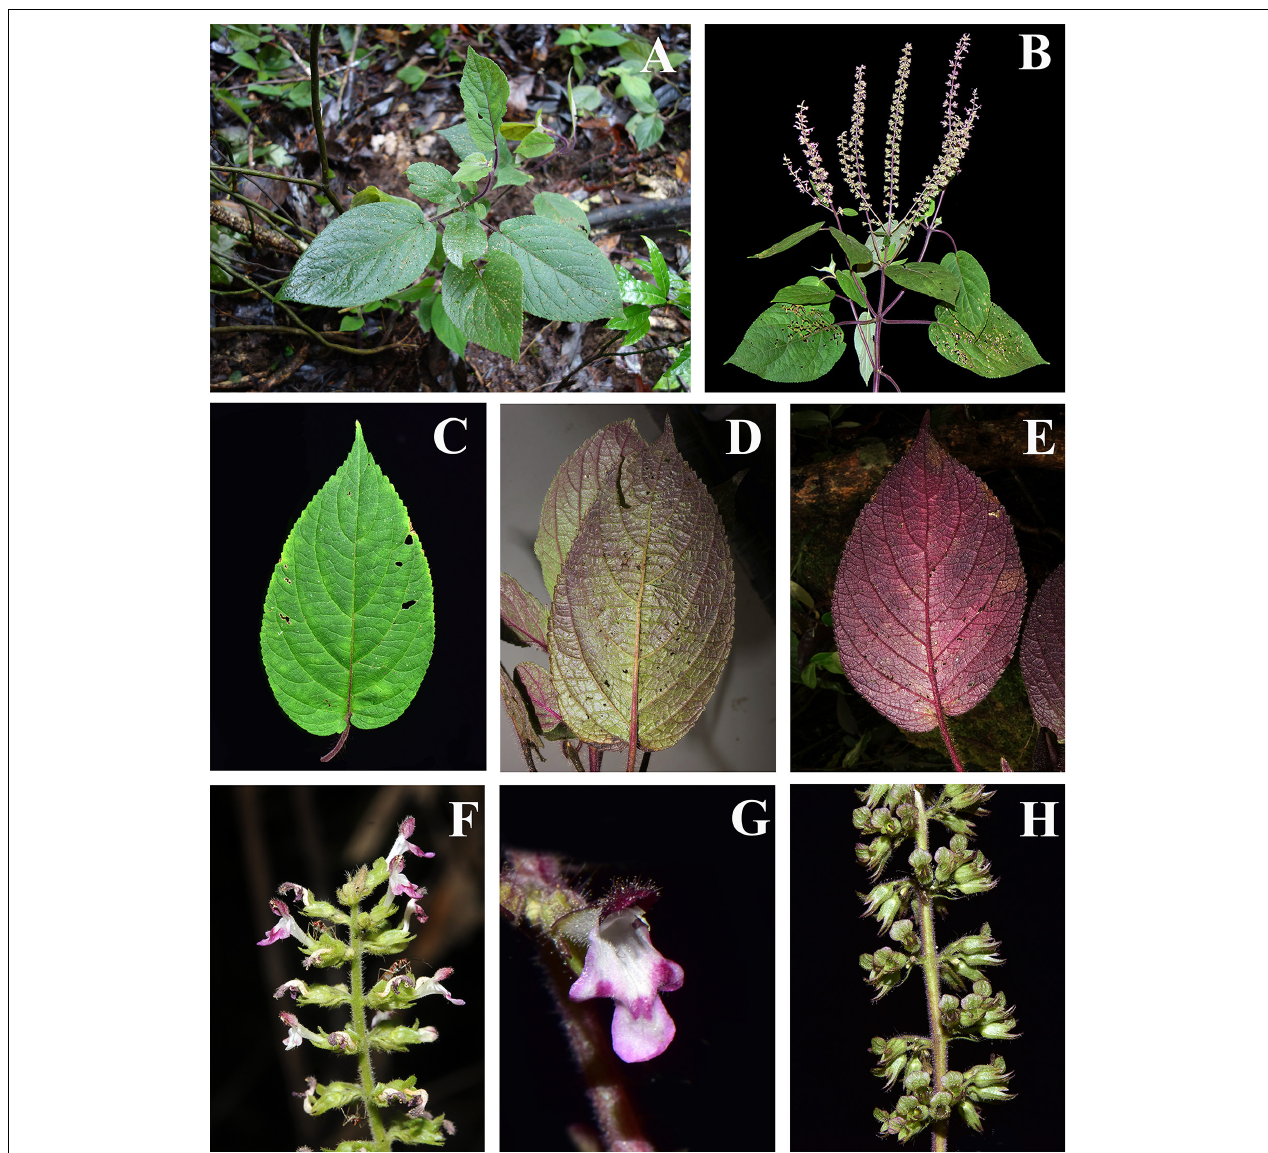
FIGURE 1 | Morphology of Paralamium griffithii . (A) Habitat; (B) plant and inflorescence; (C–E) Leaf morphology, showing the color variation of leaf blades; (F) Lateral review of inflorescence; (G) Frontal view of flower; (H) Lateral of calyx. (Photo by XX